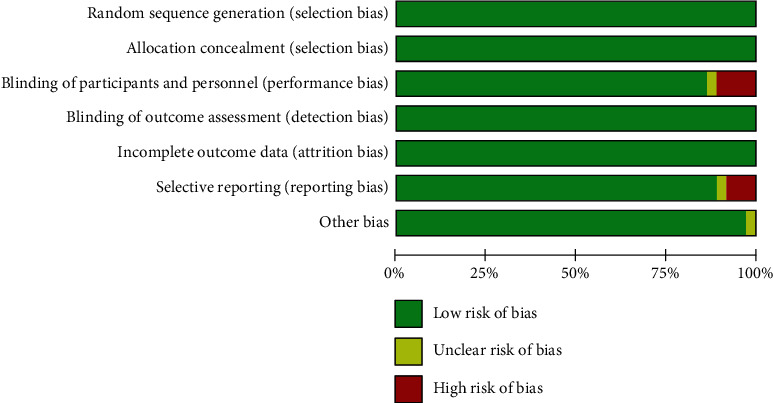
In vivo experiment quality evaluation results. This study included 36 articles with a low risk rate of more than 75 percent.